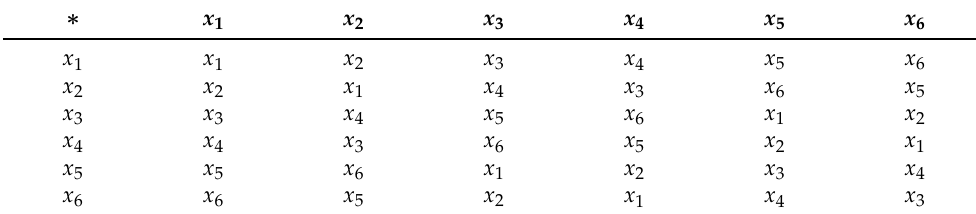
Table 5. A weak cancellative T2CA-groupoid of Example 5.